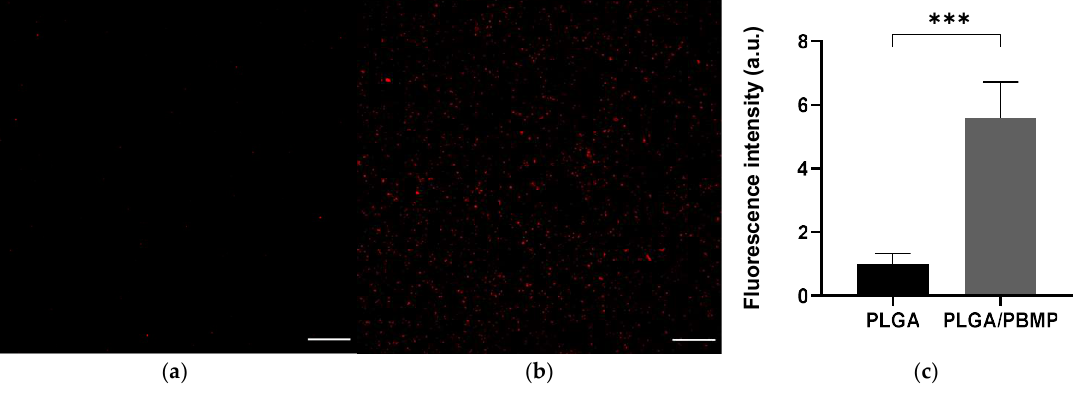
Figure 3. Enhancement of the HA-binding affinity of PLGA particles by PBMP coating. The representative CLSM images of the HA discs after incubation with Cy5.5-loaded ( a ) PLGA or ( b ) PLGA/PBMP particles, respectively. Red fluorescence indicates the position of particles. Each scale bar represents 100 μm. ( c ) Comparison of fluorescence intensities in the CLSM images. The fluorescence intensity was measured in randomly selected areas of each HA disc ( n = 12). The bar represents the mean ± SEM. The statistical analysis was performed using Student’s unpaired t -test. *** indicates p < 0.001.